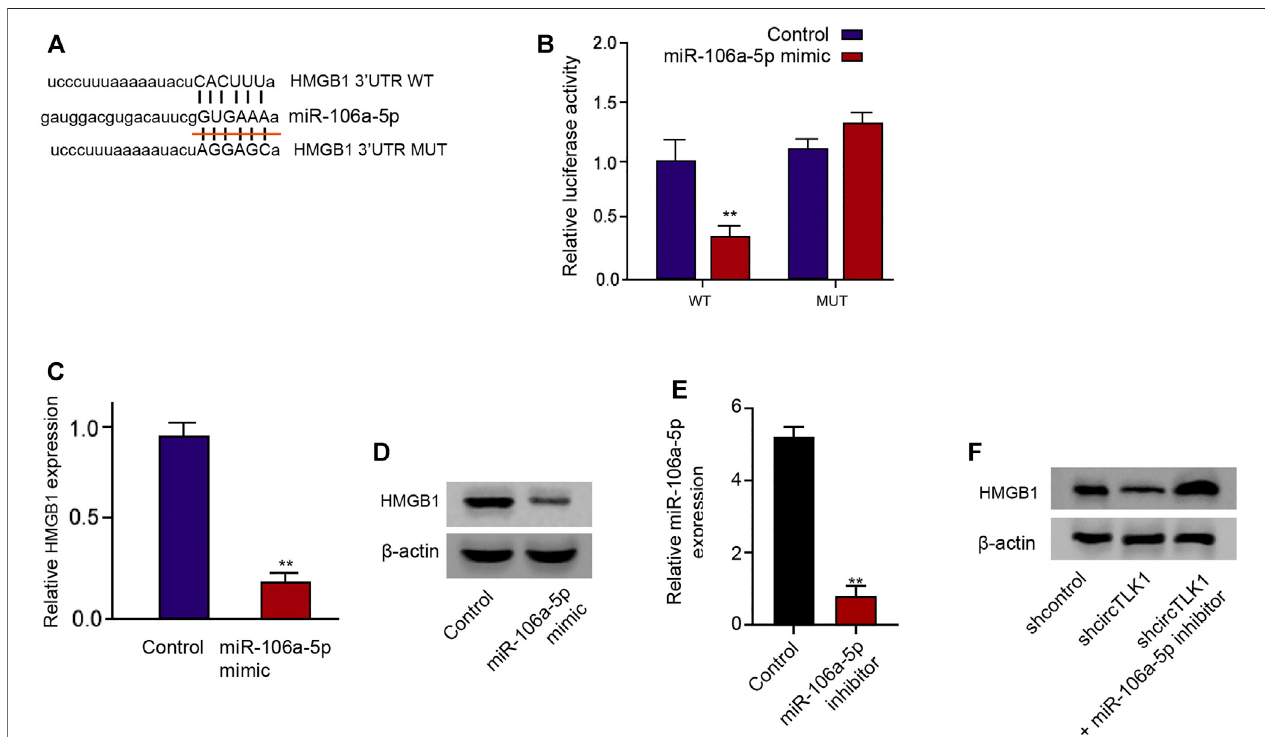
FIGURE 5 | HMGB1 is targeted by miR-106a-5p in HK-2 cells. (A) Bioinformatic analysis using ENCORI database. The sequences of miR-106a-5p, wild- type HMGB1 3 ′ UTR (WT), and mutant HMGB1 3 ′ UTR (MUT) are shown. (B – D) HK-2 cells were treated with miR-106a-5p mimic. (B) luciferase reporter gene assays of wild-type HMGB1 3 ′ UTR (WT), and mutant HMGB1 3 ′ UTR (MUT) luciferase activities. (C) qPCR assays of HMGB1 expression. (D) Western blot analysis of HMGB1 expression. (E) The expression of miR-106a-5p was detected by qPCR in HK-2 cells treated with miR-106a-5p inhibitor. (F) HK-2 cells were treated with circTLK1 shRNA, or cotreated with circTLK1 shRNA and miR-106a-5p inhibitor. Western blot analysis of HMGB1 expression, mean ± SD, ** P <